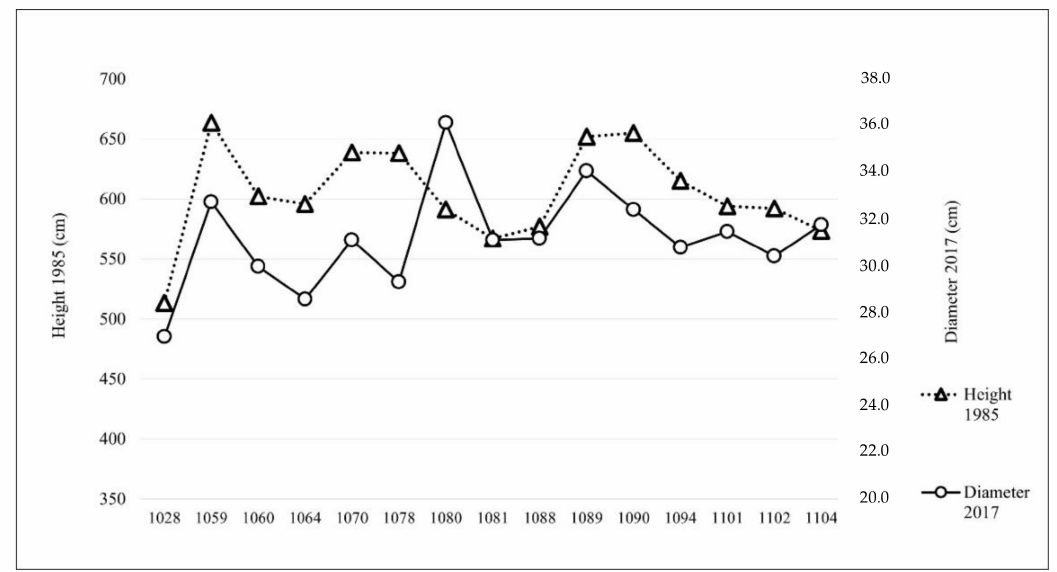
Figure 2. Data on average tree heights in 1985 and average diameter at breast height (dbh) in 2017. See Table 1 for provenance names.